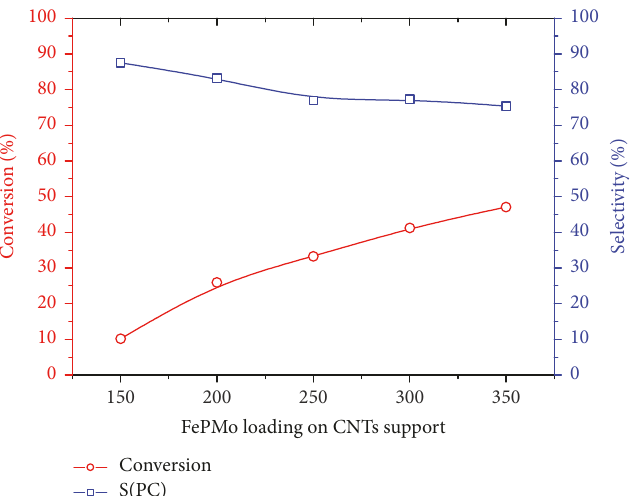
Figure 5: Effect of FePMo contents on the conversion and PC selectivity. Reactions carried out under 5-bar CO 2 pressure during a period of 7 h by using 0.150 g of catalyst and 0.050 g of TEABr (cocatalyst).